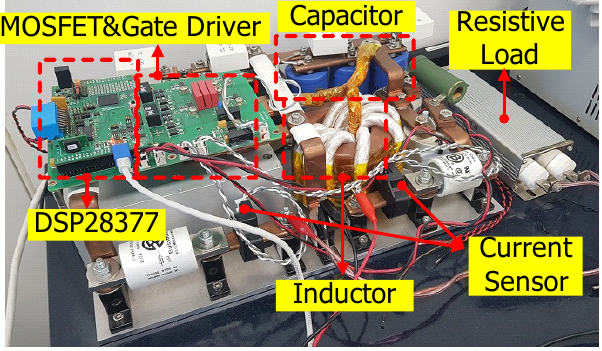
Figure 6. Prototype 3-kW DC/DC power conversion hardware